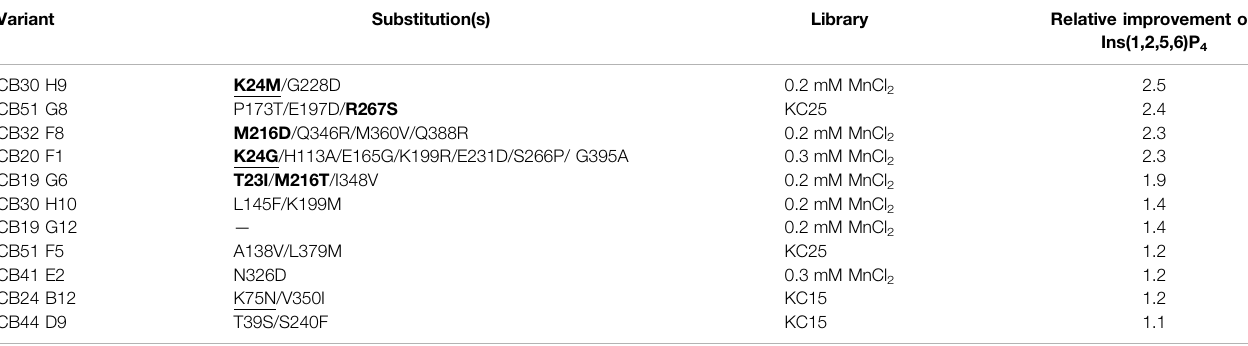
TABLE 1 | Summary of the 11 improved variants obtained during screening and rescreening of error-prone PCR (epPCR) libraries. Variant